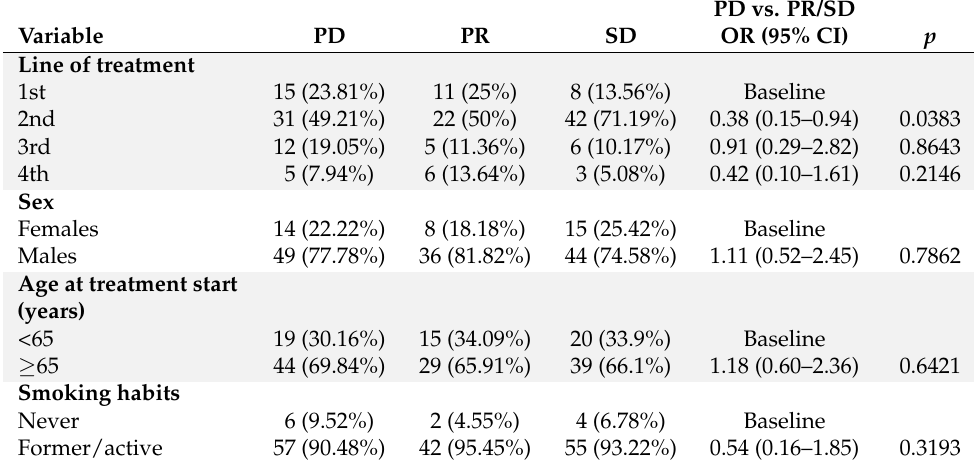
Table 2. Association between variables of interest and best response. Variable = analyzed variable and corresponding values; PD = absolute and relative frequency (%) of patients by variable’s category among those with best response type PD; PR = absolute and relative frequency (%) of patients by variable’s category among those with best response type PR; SD = absolute and relative frequency (%) of patients by variable’s category among those with best response type SD; * p < 0.05; # Including soft tissues and adrenal